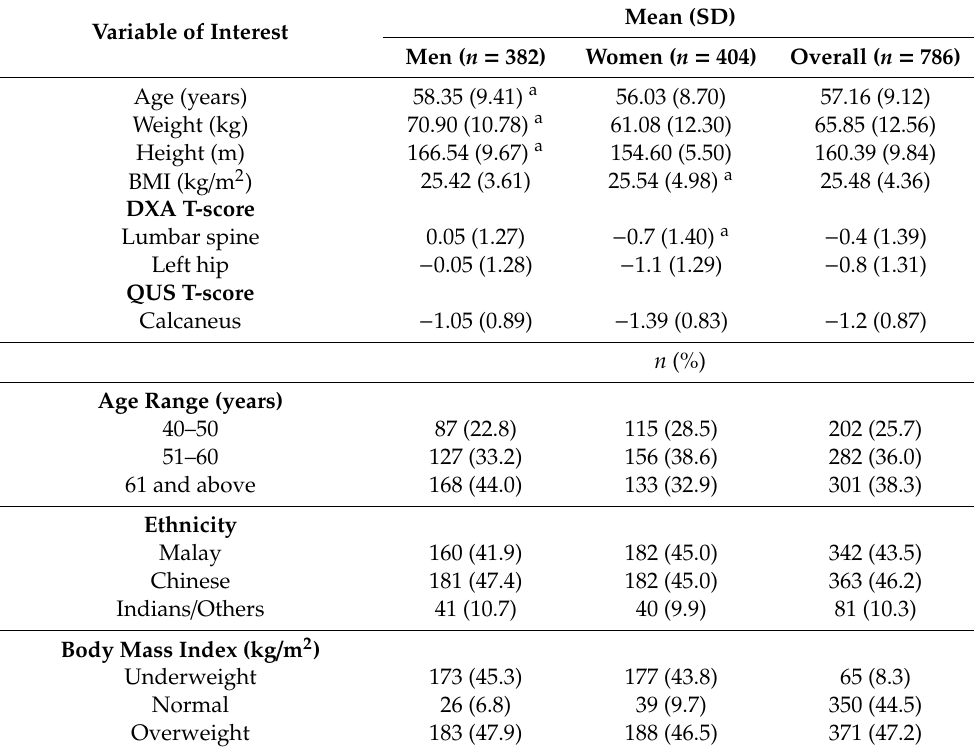
Table 1. Basic characteristics of the